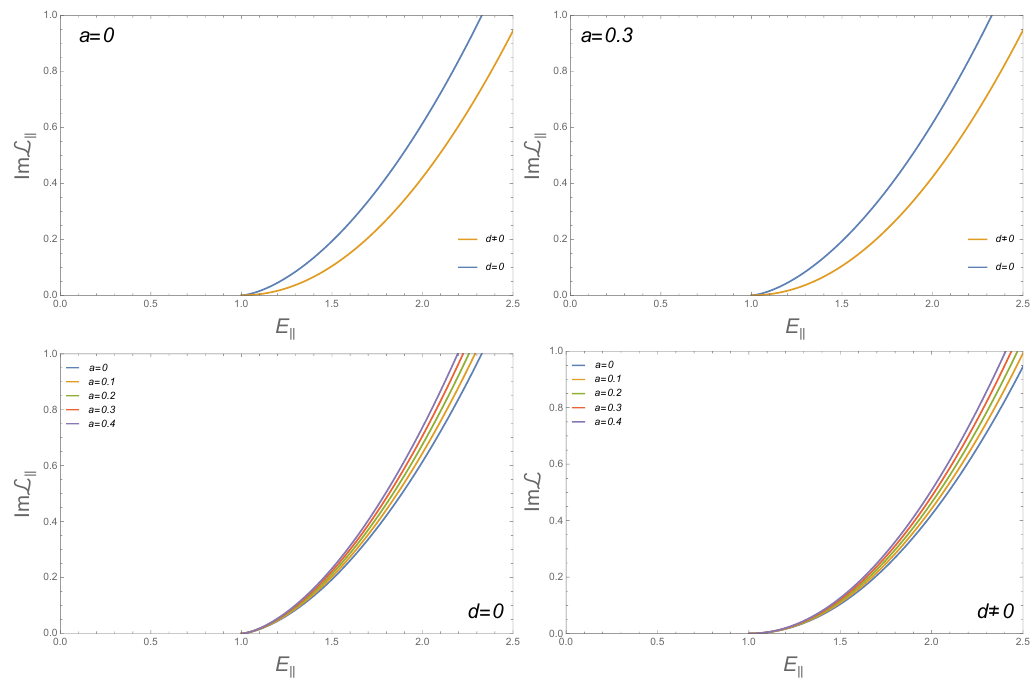
with various a k